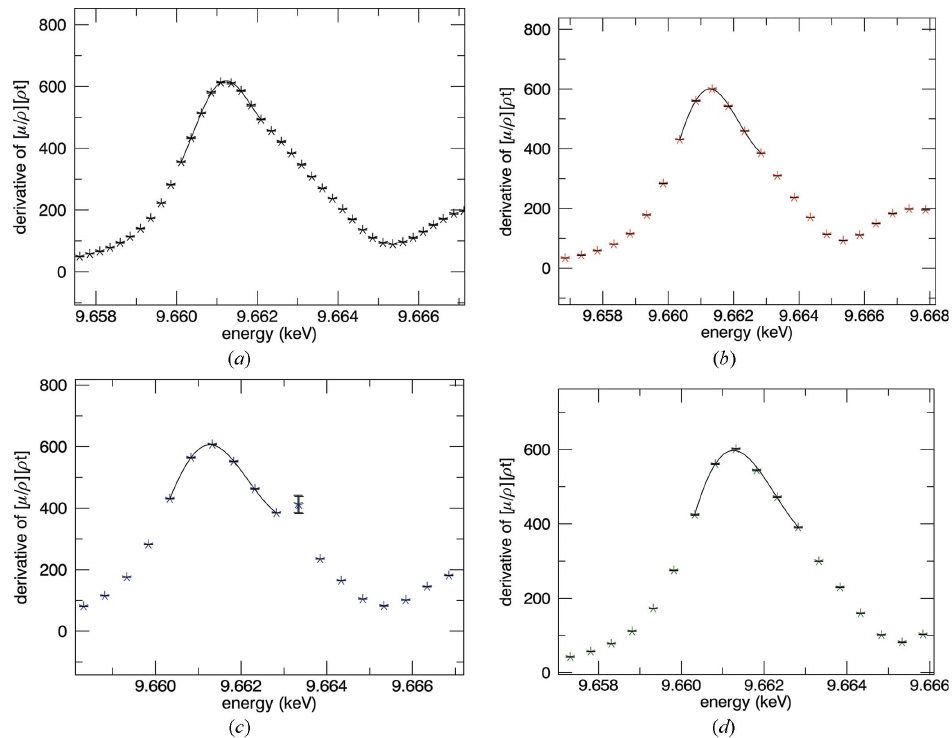
Figure 26 Determination of the Zn K absorption edge by finding the first peak in the derivative spectra for ( a ) 10 K, ( b ) 50 K, ( c ) 100 K and ( d ) 150 K. The energy is determined to a fraction of the point spacing. Table 5 Determination of the absorption edge by finding the first peak in the derivative spectra.